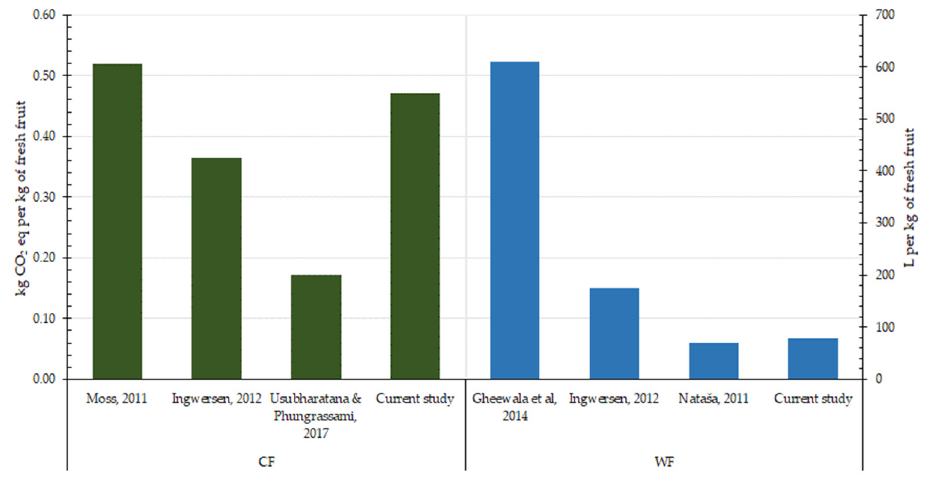
Figure6. Figure 6. Comparison of the carbon footprint and water footprint between different authors [18,21,56– 58].